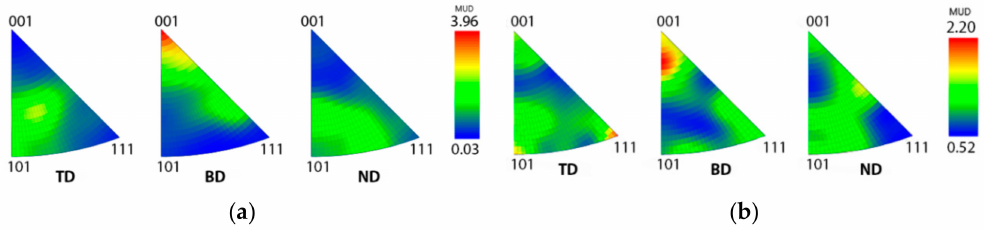
Figure 8. Pole figures of the body-centered cubic (BCC) ferrite phase in the as-built samples with di ff erent scanning strategies: ( a ) No scanning direction rotation between layers and ( b ) scanning direction rotated 66 ◦ between layers. TD = transverse to building direction, BD = building direction, and ND = normal to building direction.